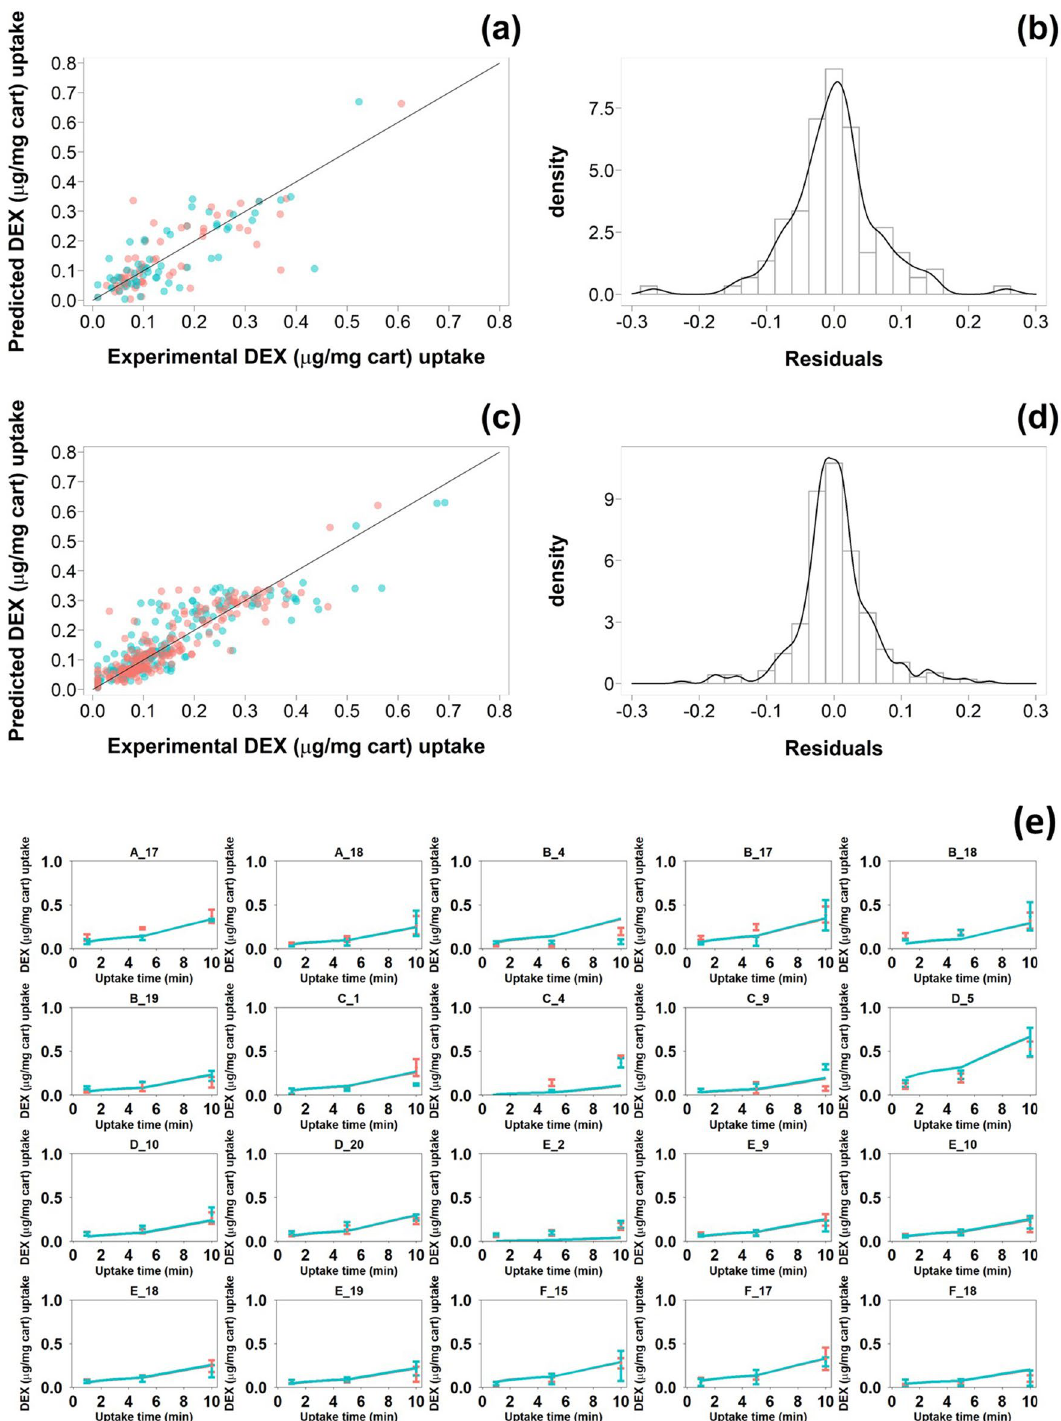
optimised bag MARS model for PBAE in the test dataset ( e